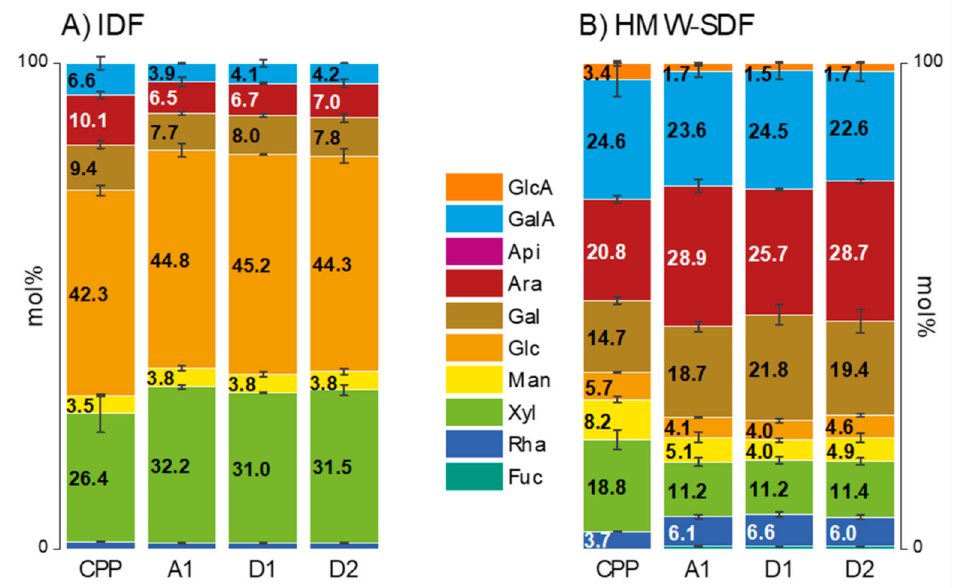
Figure 2. Monosaccharide composition of ( A ) insoluble dietary fiber (IDF) and ( B ) high molecular weight soluble dietary fiber (HMW-SDF) from chokeberry pomace powder (CPP) and samples after extrusion processing at different water contents (c w ) and specific mechnical energies (SME) applied resulting in different material temperatures (T M ) (mol%, range/2, n = 2). (A1) SME 145 ± 6 Whkg − 1 , T M 136 ◦ C; (D1) SME 222 ± 10 Whkg − 1 , T M 155 ◦ C; (D2) SME 190 ± 9 Whkg − 1 , T M 140 ◦ C.